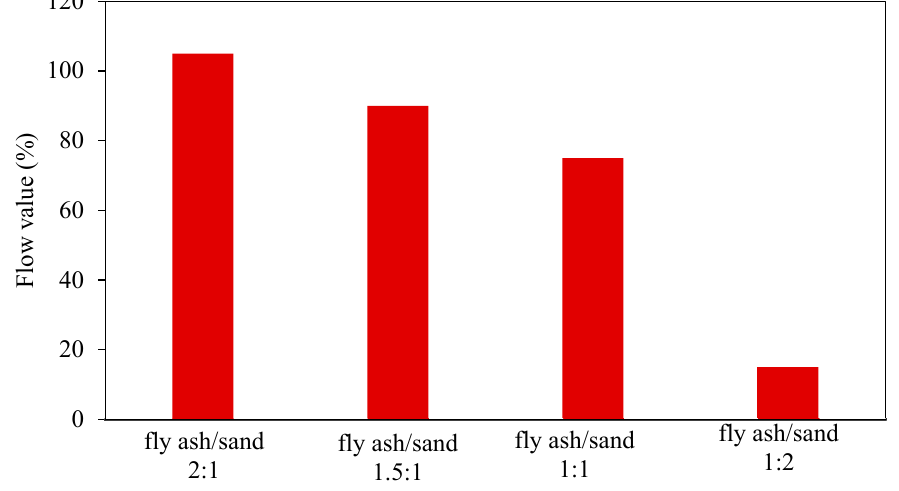
Figure 7. Flow value vs. fly ash/sand ratio [39].